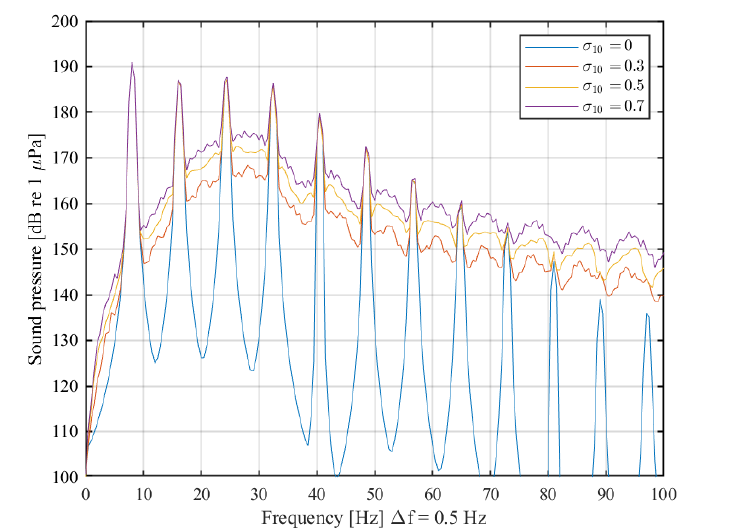
Figure 11. Sound pressure spectra of artificial signals generated by variation of the 10 th control point defining the collapse region based on three different standard deviations σ 10 in comparison to the unvaried signal (blue line) for 96.5